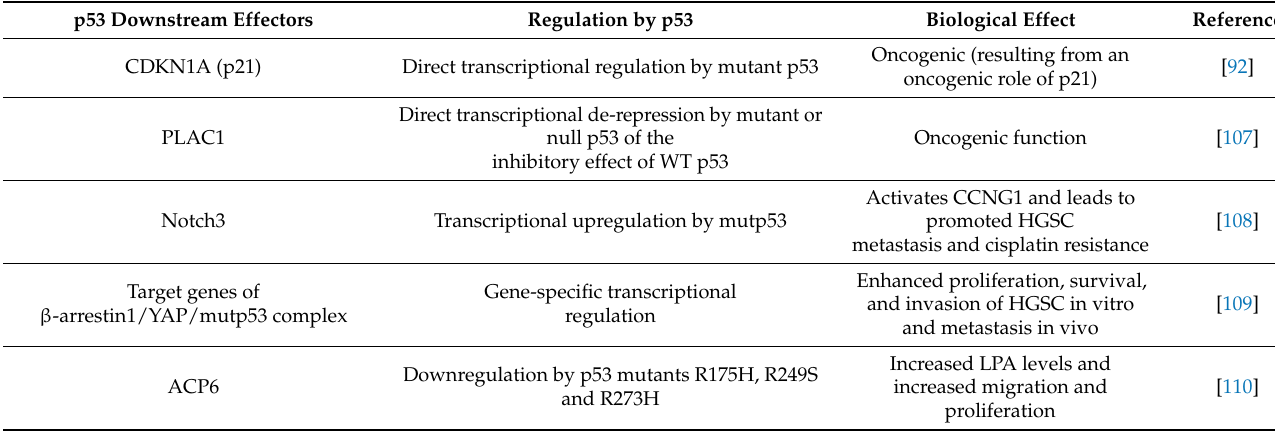
Table 2. Downstream targets of p53 in